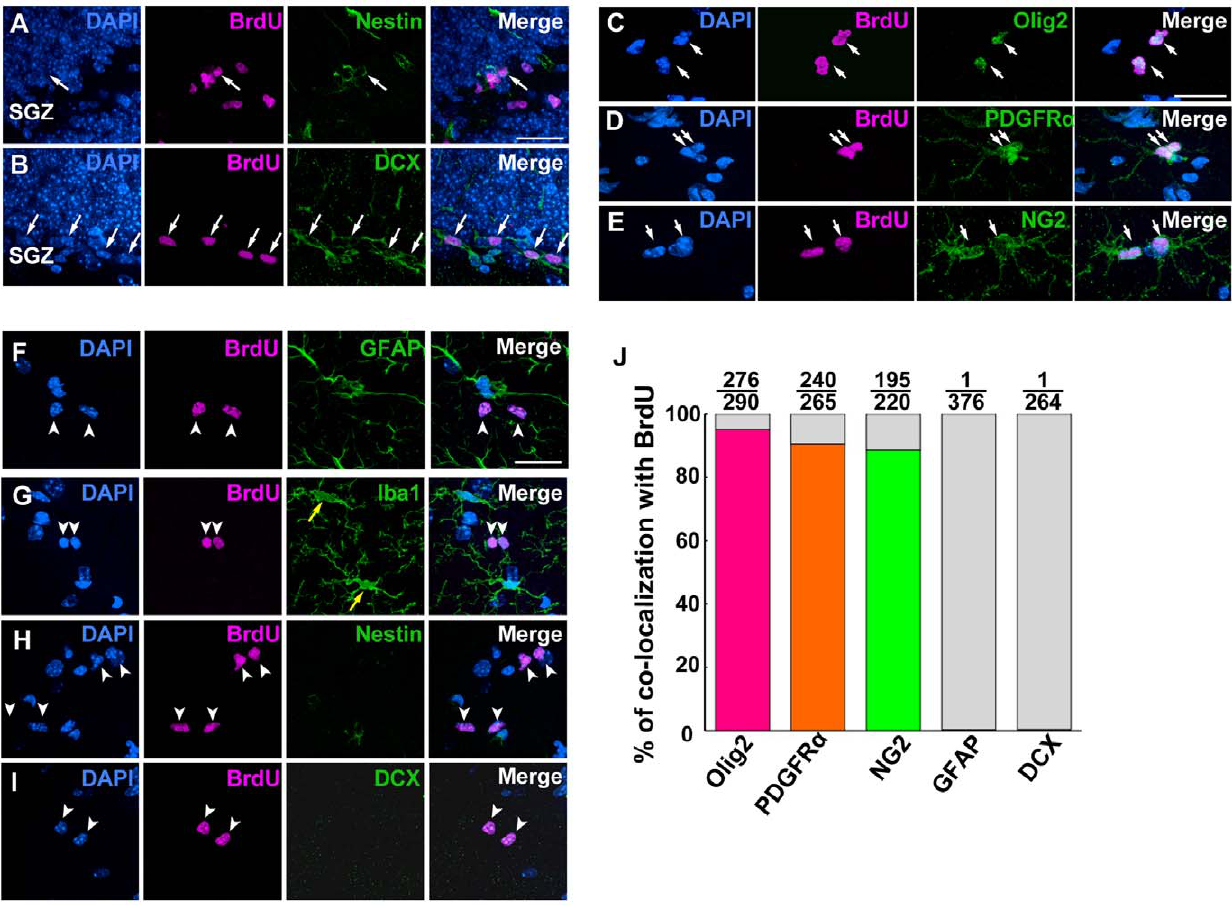
Figure 1. Analyses of cell-type specific markers in BrdU-positive cells in the hippocampal neurogenic area and non-neurogenic area. (A, B) Immunostaining with anti-BrdU, anti-nestin (A), and anti-DCX (B) antibodies in the neurogenic area. White arrows indicate BrdU-positive cells labeled with neural stem/progenitor cell markers. (C to E) Double immunostaining with anti-BrdU and anti-Olig2 (C), anti-PDGFR a (D), or anti-NG2 (E) antibodies in the non-neurogenic area. White arrows indicate BrdU-positive cells labeled with each OPC marker (C to E). Note that the dividing OPCs extend processes. (F to I) Double immunostaining with anti-BrdU and anti-GFAP (F), anti-Iba1 (G), anti-nestin (H) and anti-DCX (I) antibodies in the non-neurogenic area. White arrowheads indicate BrdU-positive cells that are negative for GFAP (F), Iba1 (G), nestin (H), and DCX (I). Yellow arrows indicate Iba1-positive cells (G). (J) The percentage of cells positive for each marker among all BrdU-positive cells. Scale bars: 20 m m (A to I).